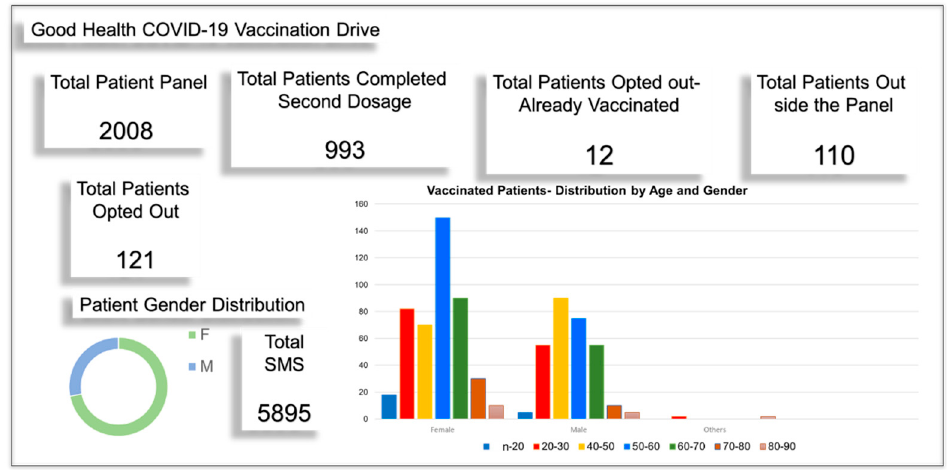
Figure 3. The GHAC achieved higher vaccination rates vs. surrounding Rutherford County .